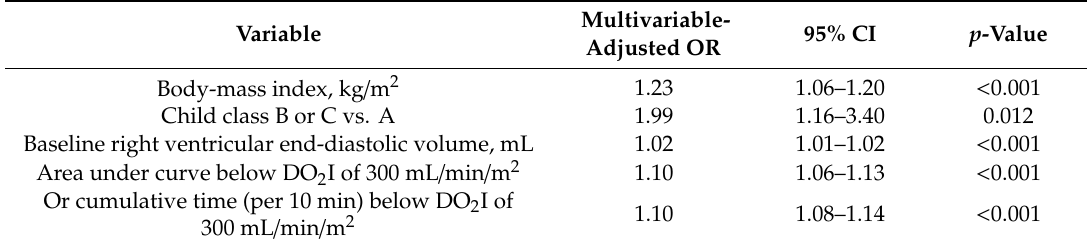
Table 2. Multivariable logistic regression analysis for acute kidney injury after liver transplantation in all patients ( n = 676).